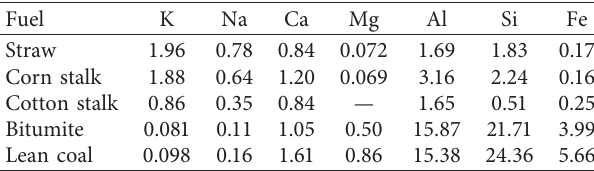
Table 2: Major ash constituents in fuels